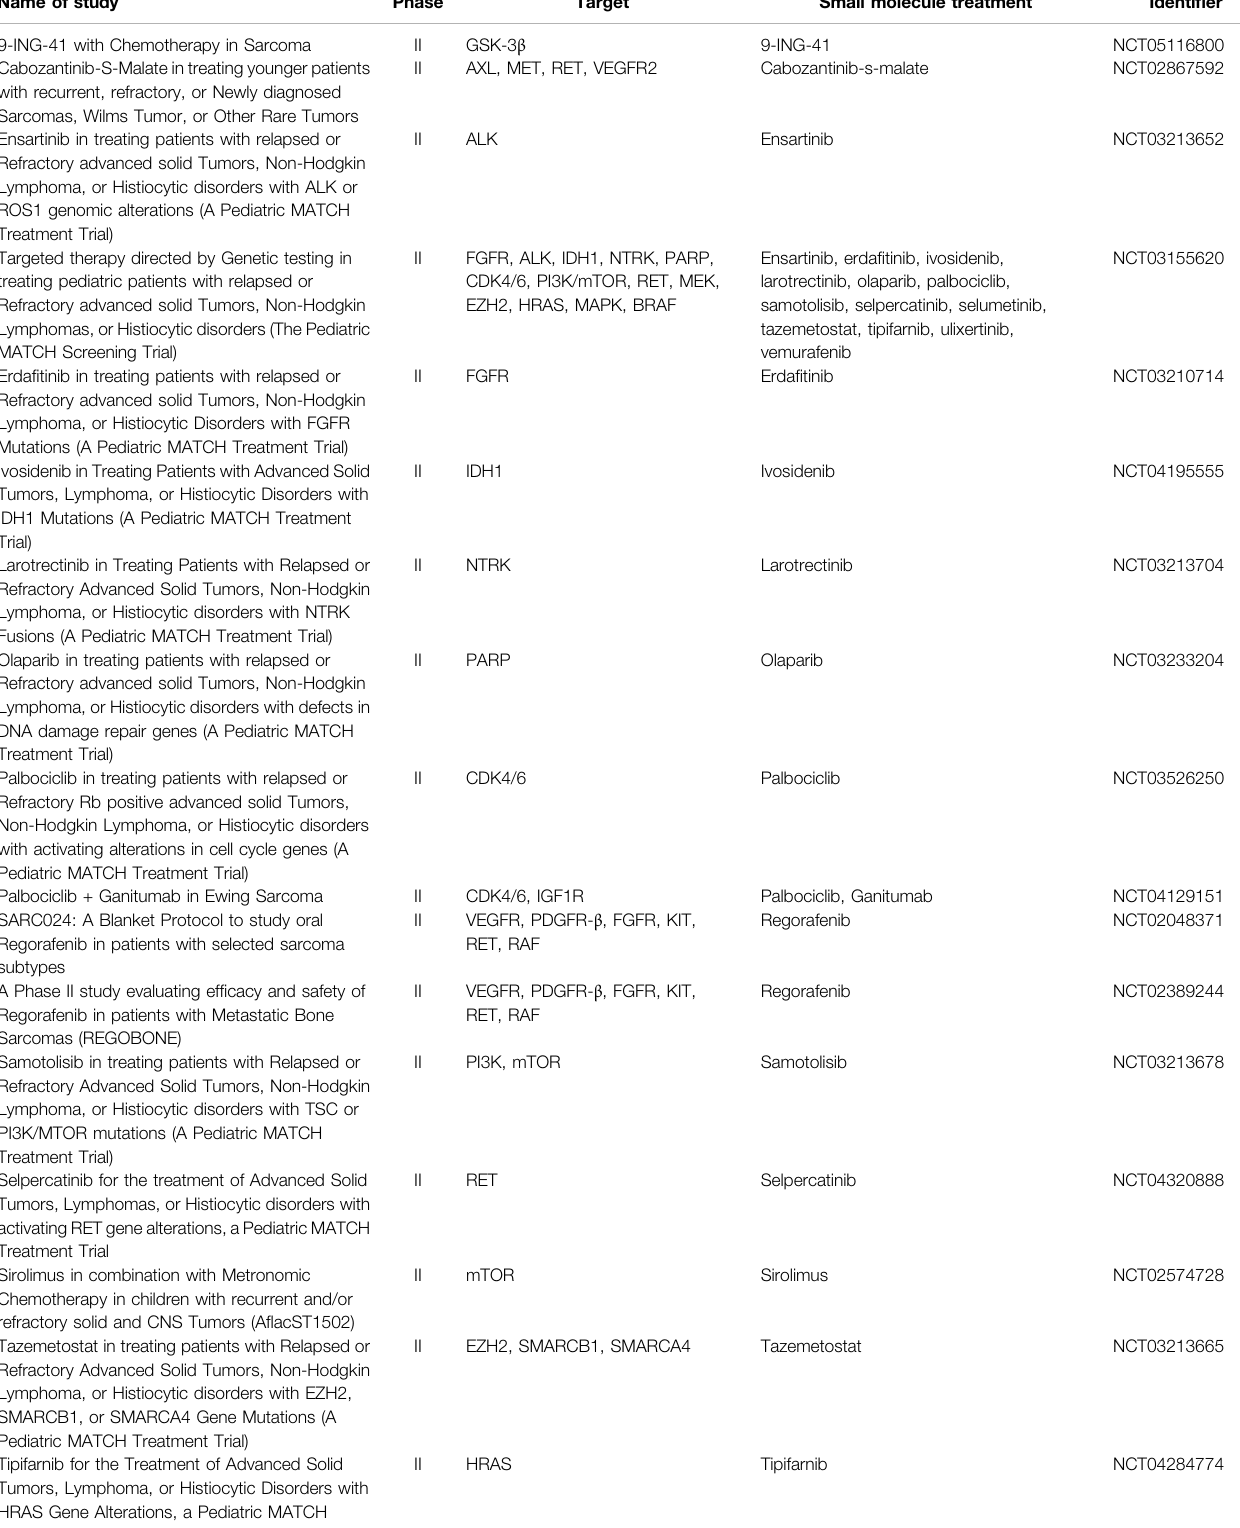
TABLE 2 | Small Molecule Clinical Trials that are Recruiting or Active for Adolescent or Pediatric Ewing Sarcoma Patients (All Data from